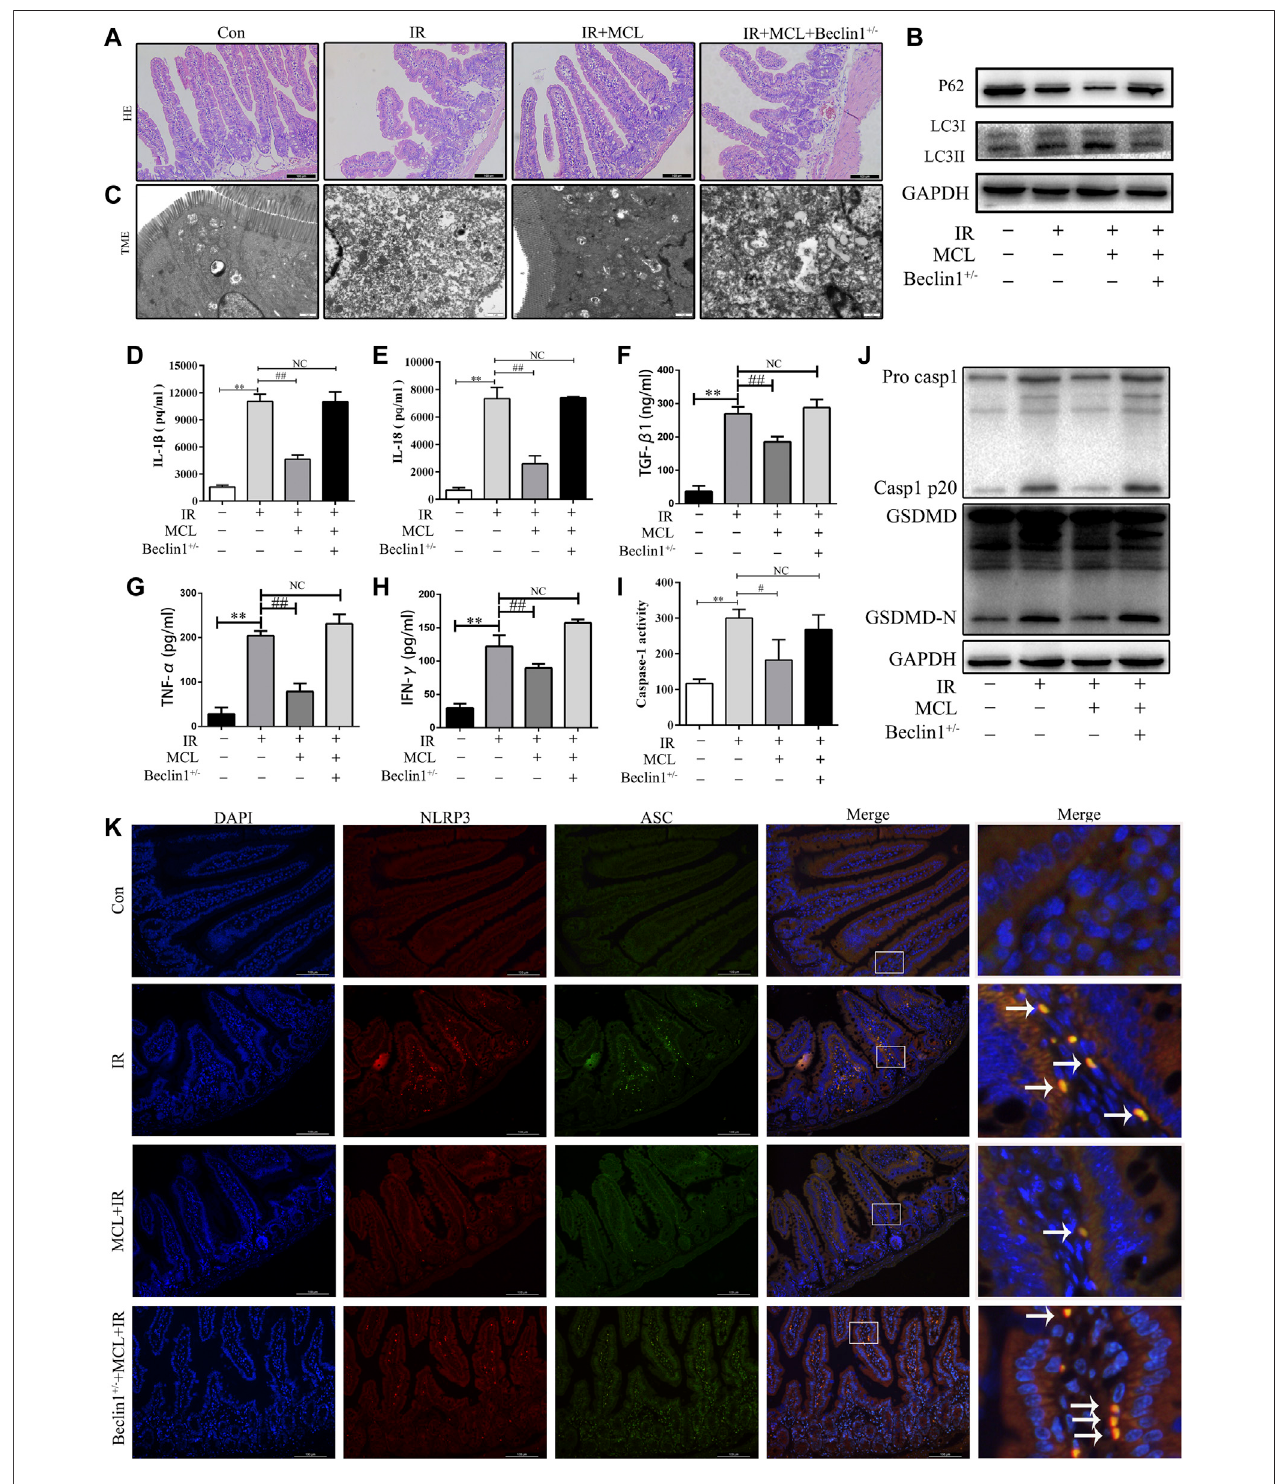
FIGURE 7 | Micheliolide (MCL) inhibits the NLRP3 in fl ammasome via the activation of autophagy (A) Representative small intestine hematoxylin and eosin staining from Beclin1+/-and wild-type (WT) mice following irradiation (B) Western blotof p62 and LC3 protein expression (C) Autophagosomes in small intestinetissue detected by transmission electron microscopy (D) Serum IL-1 β levels in MCL-treated heterozygous beclin 1 knockout mice following radiation (E) Serum IL-18 levels in MCL- treated heterozygous beclin 1 knockout mice following radiation (F) Serum TGF- β 1 levels in MCL-treated heterozygous beclin 1 knockout mice following radiation (G) Serum TNF- α levels in MCL-treated heterozygous beclin 1 knockout mice following radiation (H) Serum IFN- γ levels inMCL-treated heterozygous beclin 1knockout